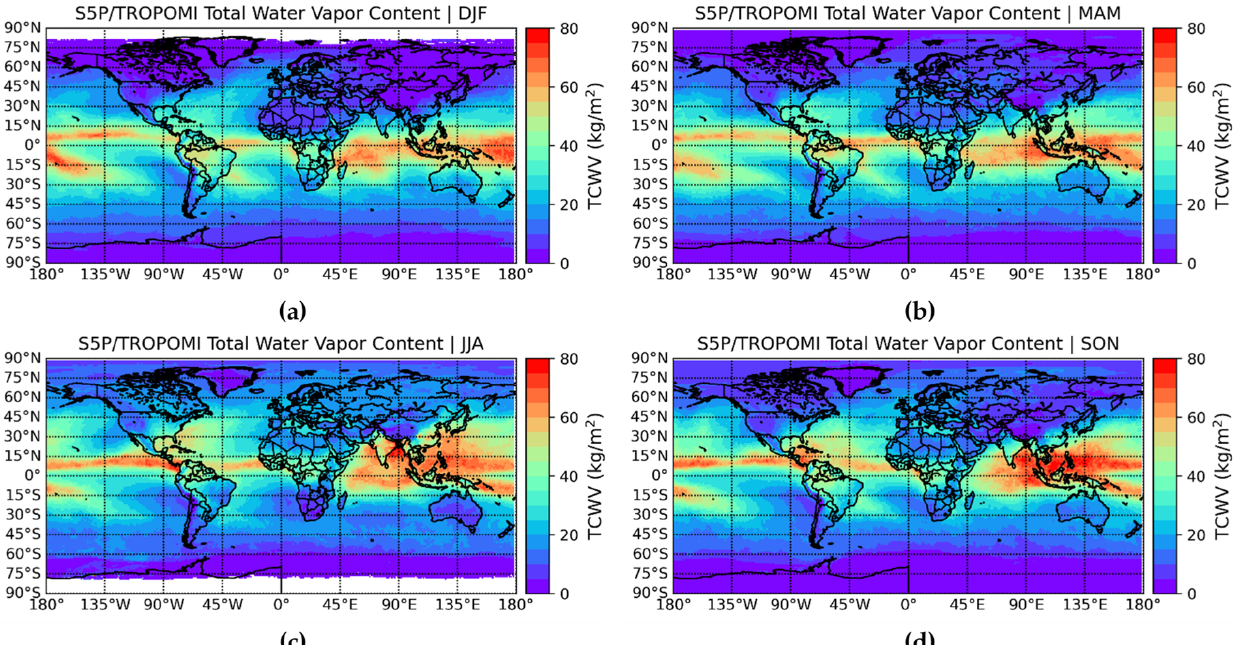
Figure 1. Seasonal global maps of the TROPOMI/S5P TCWV product (in kgm − 2 ). (a) December–February, (b) March–May, (c) June– August and (d)